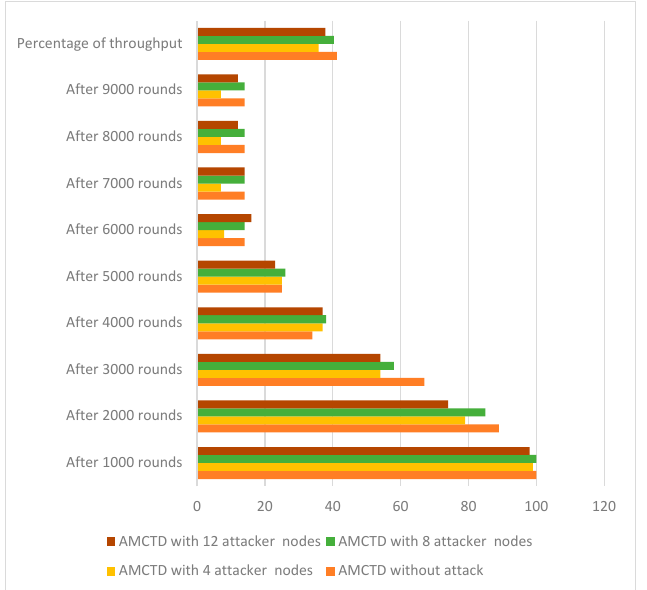
Figure 9. Throughput of AMCTD without Attack, AMCTD with 4, 8 and 12 Attacker Nodes.